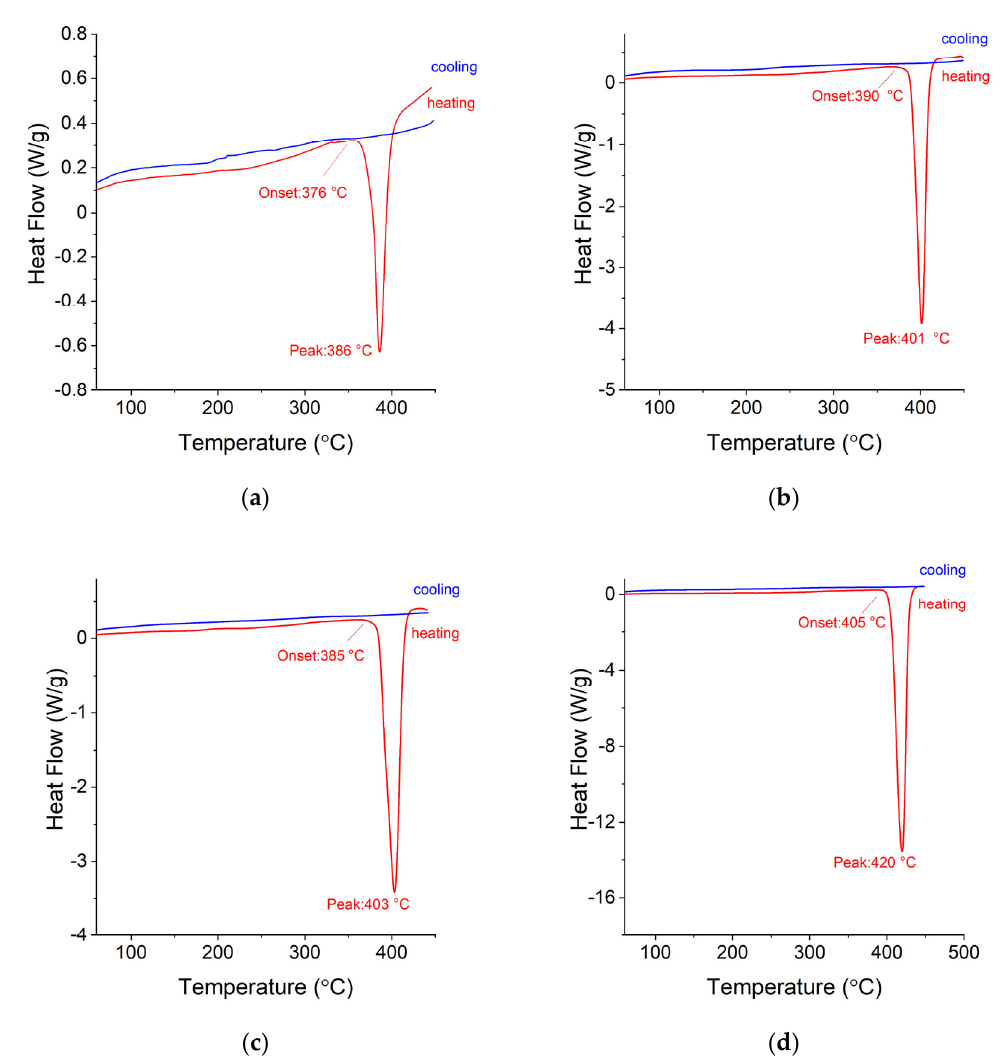
Figure 11. DSC curves obtained for ( a ) Alloy 7, ( b ) Alloy 6, ( c ) Alloy 5, and ( d ) Alloy 2.